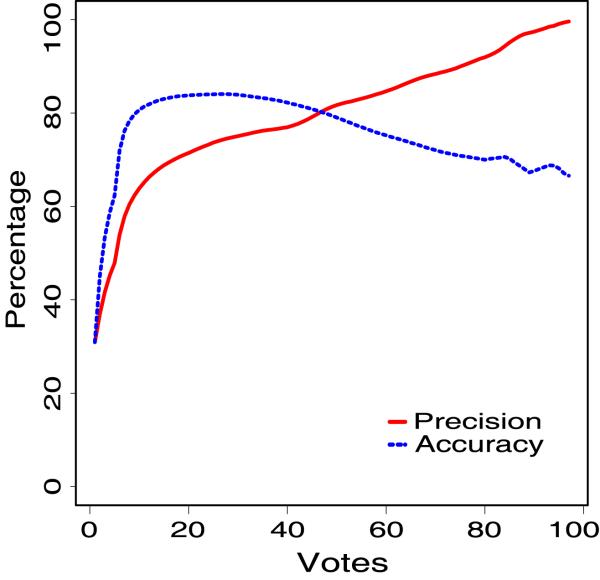
Accuracy and precision against the number of votes: The accuracy and precision values of the test data is plotted against the number of votes. An increasing number of votes increased the precision monotonically. Higher stringency yielded a sparse lowering of the accuracy due to the rate of false negatives. The relation between the precision and the number of votes was used for assigning confidence values for new predictions.